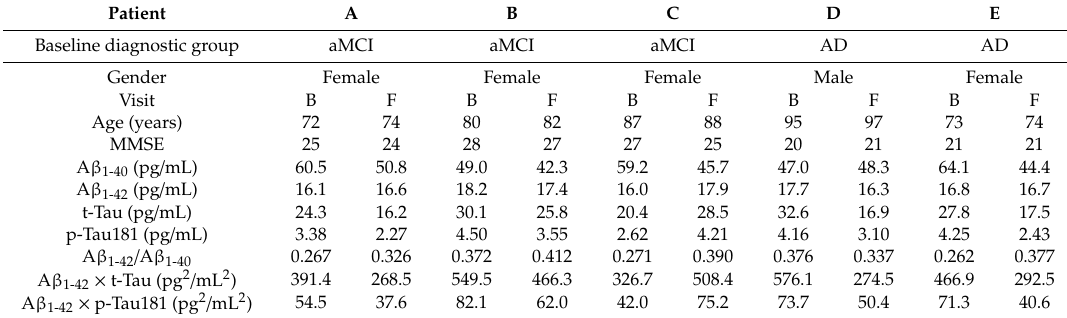
Table 2. Demographic information of the five patients with aMCI / AD enrolled in the longitudinal study. Patient A